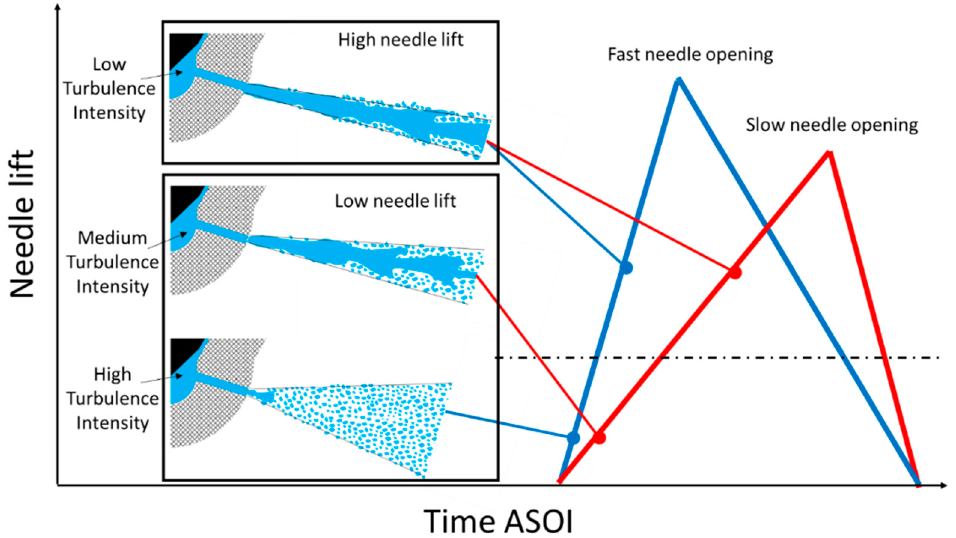
Figure 11. Needle motion profile effect on the spray dynamics.